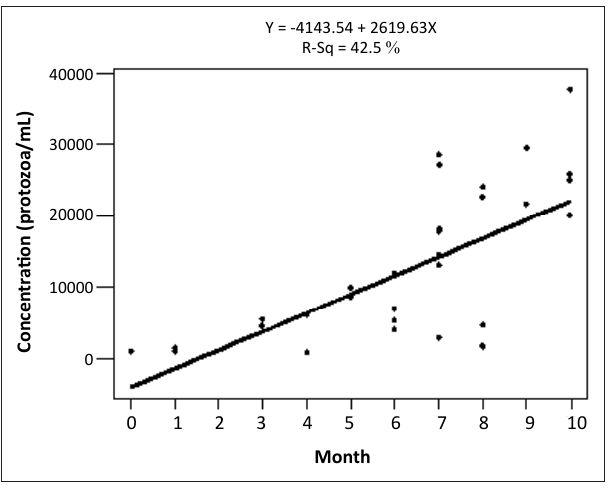
Month FIGURE 1: Regression of concentration of the larger protozoa in impala rumen contents according to the month of collection.